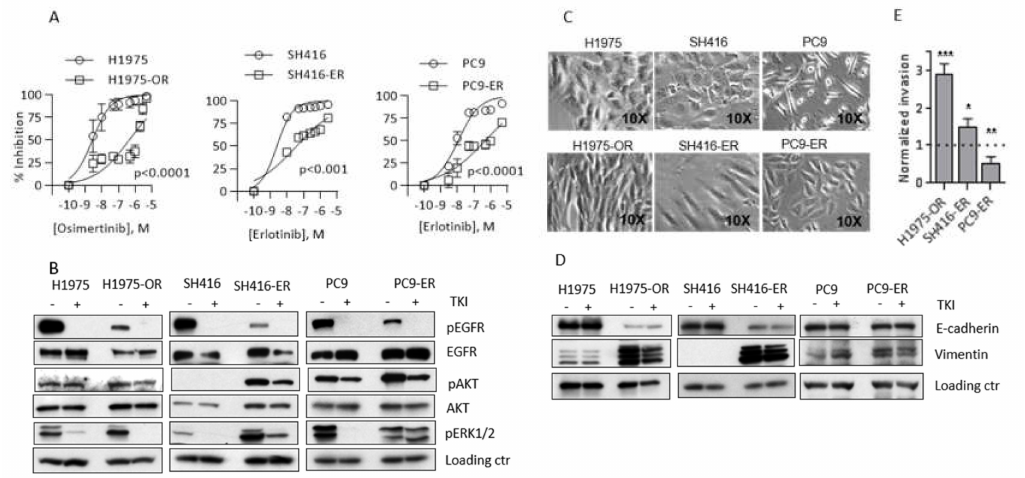
Figure 2. Prolonged exposure to EGFR tyrosine kinase inhibitors (EGFR TKIs) produces cells with different mechanisms of EGFR TKI-resistance. ( A ) H1975 cells were treated with 0.5 µ M osimertinib every 72 h for at least 30 days to produce H1975–OR cells. SH416 and PC9 cells were treated with 1 µ M erlotinib every 72 h for at least 30 days to produce SH416–ER and PC9–ER cells. Dose-response studies were conducted to determine IC50 and IC80 values for parental cells and their established EGFR TKI-resistant derivatives. Drug response was measured after 9 days of treatment using sulforhodamine B (SRB) assay. The results shown for each model are the average ( +/ -SD) from 3 independent experiments. ( B ) The indicated cell lines were left untreated (-) or treated ( + ) with 0.5 µ M osimertinib (H1975 and H1975–OR) or 1 µ M erlotinib (SH416, SH416–ER, PC9, PC9–ER) for 24 h. Expression of EGFR and its downstream effector molecules were investigated by Western blot. Loading controls used: β -Actin for H1975 / H1975–OR, PC9 / PC9–ER; α -tubulin for SH416 / SH416–ER. Quantitative band analysis is shown in Table S2. ( C ) Images of individual models were captured by phase contrast microscopy. ( D ) Expression of E-cadherin and vimentin was investigated by Western blot as an indicator of EMT. Images are representative of three independent experiments. Loading controls used: β -Actin for H1975 / H1975–OR, PC9 / PC9–ER; α -tubulin for SH416 / SH416–ER. Quantitative band analysis is shown in Table S3. ( E ) Parental cells and their TKI-resistant derivatives were subjected to transwell invasion assay, as described in Methods. The results shown are pooled from 3 independent experiments per cell line. Values obtained for drug-resistant cells were normalized to the corresponding parental cell line (arbitrarily set to an invasion score of 1.0 and represented by the dotted line). * p < 0.05; ** p < 0.01; *** p <